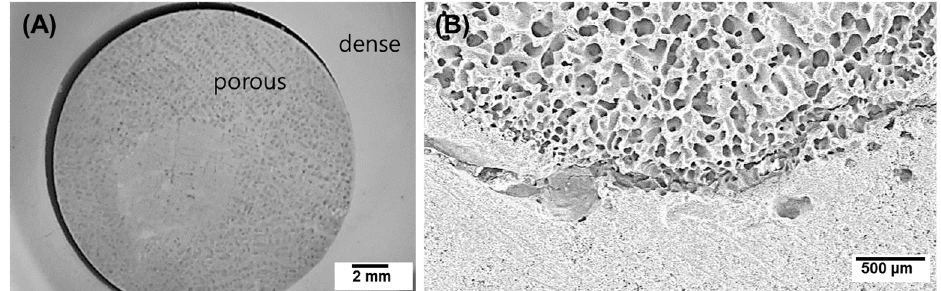
Figure 5. ( A ) Optical and ( B ) SEM images of a porous HA scaffold with a bone-like structure: inner initial HA content = 10 vol %, and outer initial HA content = 50 vol %.